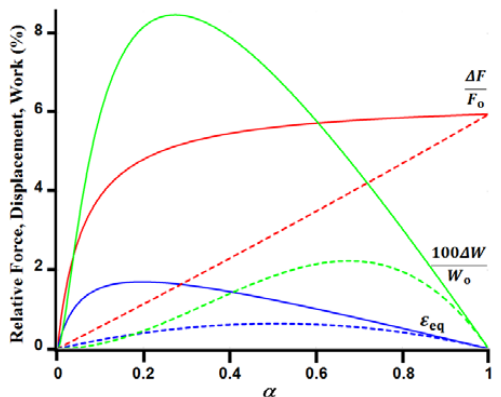
Figure 2. Photomechanical response of an elastomeric strip as a function of α , the fractional length of the strip that is heated. The dashed curves are for a fixed temperature increase where the heated section is raised 17.85 K above 300 K (Equations (2)–(4)). The solid curves are for a fixed amount of heat energy where the heat energy Q is 0.227 J, corresponding to the entire strip being raised, on average, 17.85 K above 300 K, or equivalently, the heated section is heated by 17.85/ α K (Equations (3) and (4) and (6)).